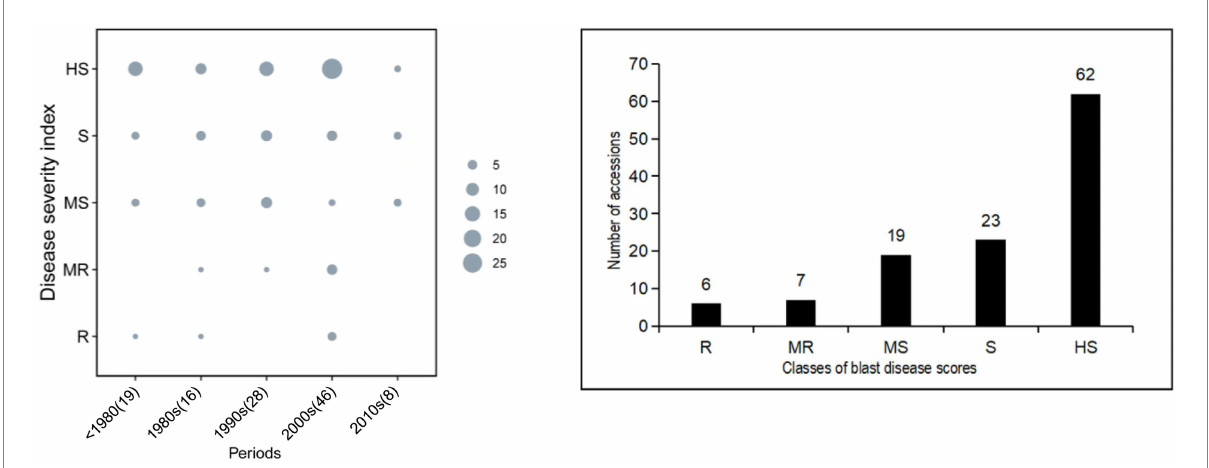
FIGURE 2 Distribution of blast-resistance scores for the 117 cultivars in the field test. Period: A, >1980; B, 1980s; C, 1990s, D, 2000s; E, 2010s. HR, highly resistant; R, resistant; MR, moderately resistant; MS, moderately susceptible; S, susceptible; HS, highly susceptible.